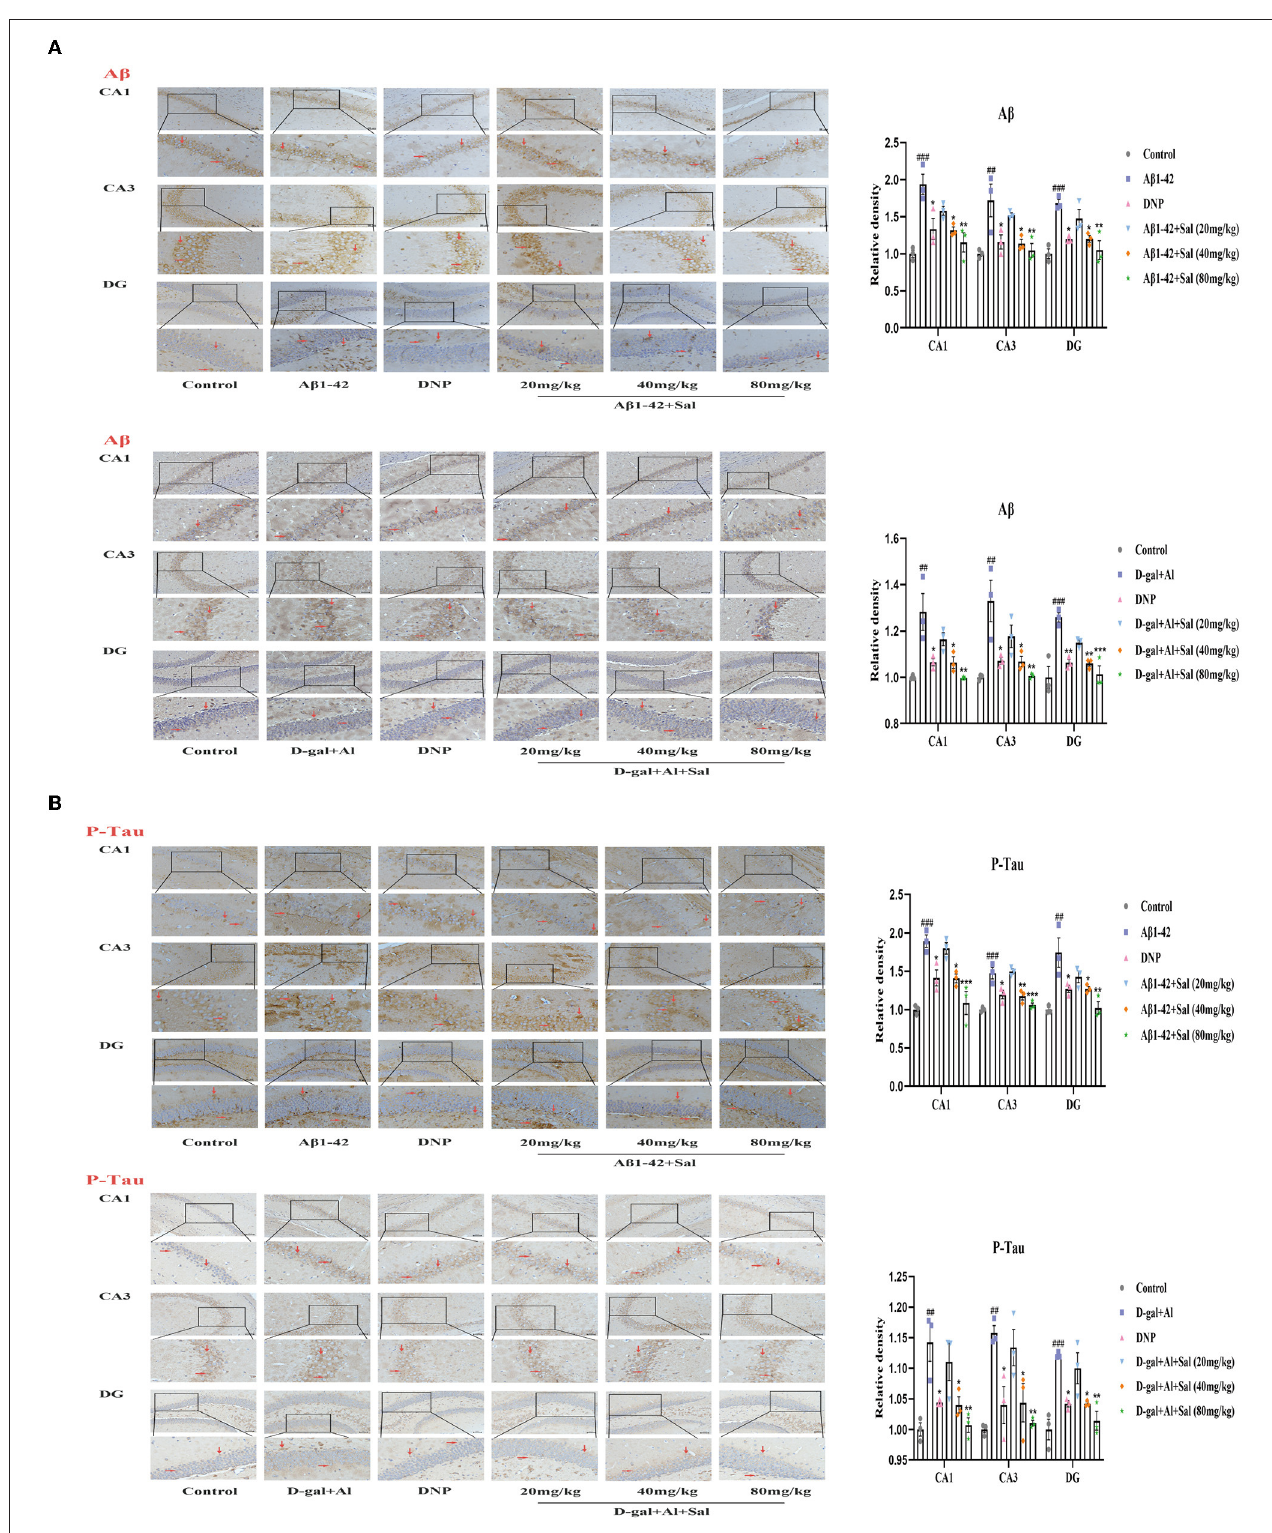
FIGURE 5 | Sal reduced A β , P-Tau in A β 1-42 and D-gal/AlCl 3 -induced AD mice. Immunochemical staining of A β (A) and P-Tau (B) in the CA1, CA3, and DG regions of the hippocampus, representative of the relative density of related protein in the hippocampus. A β and P-Tau staining results are shown by arrows. Scale bar = 50 µ m, the magnification of merge is 200 × . All data are represented as mean ± SEM ( n = 3). ## P < 0.01, ### P < 0.001 vs. control group, * P < 0.05, ** P < 0.01, *** P < 0.001 vs. A β 1-42 and D-gal/AlCl 3 group.